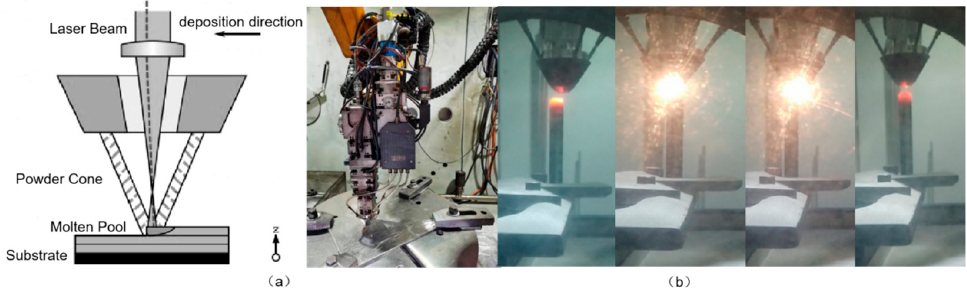
Figure 1. Additive manufacturing scenario: ( a ) metal additive manufacturing printer nozzle system; ( b ) image when 3D printing. ( b ) image when 3D